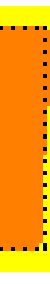
Figure 3. Rectangular Fitting for a door. (a) The orange polygon is generated by the SRF and the dashed line represents the rectangle with minimum